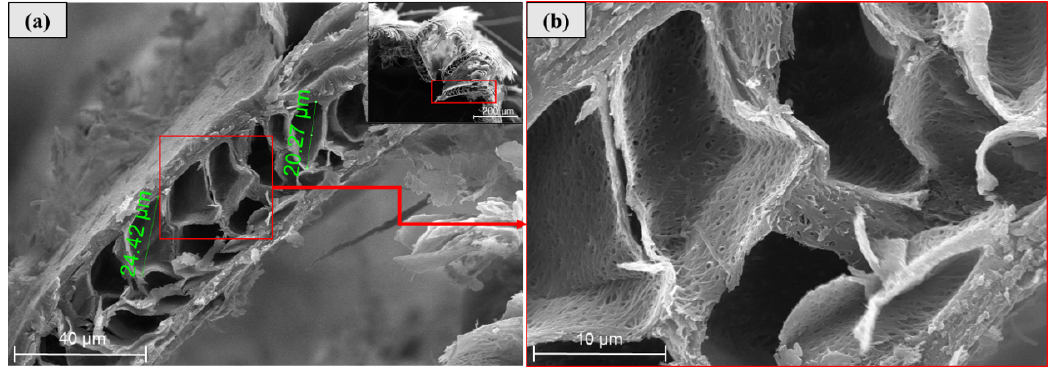
Figure 10. SEM of BPFs: ( a ) Barb cross section and ( b ) magnified view of the barb cross section.